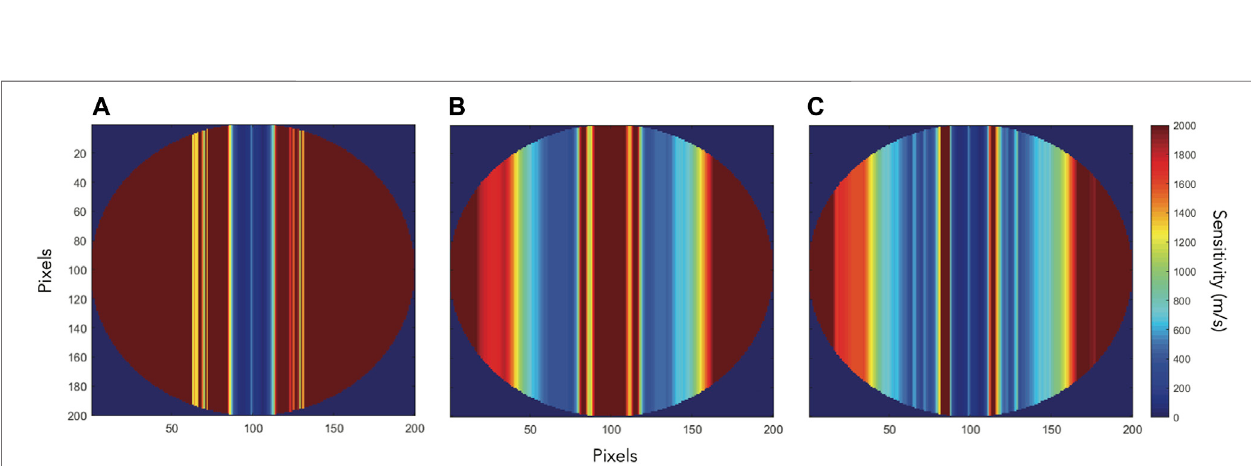
FIGURE 2 | (A) : “ velocity ” or “ MOF ” image, displaying the absorption line feature near the top of the disk. (B) : “ continuum ” image, with no velocity sensitivity, recorded simultaneously and on the same detector as the velocity image. (C) : the velocity image divided by the continuum image to produce the fi nal data product: a Dopplergram, where pixel intensity values correspond to Doppler velocities towards and away from the observer within the dark absorption band. This data was collected during the 24-day observing run on the AEOS 3.6 m telescope. Particularly, these frames are from the night of 12 August 2020, with a 13.76 km s − 1 relative velocity between observer and Jovian disk center. All three frames are from a single integration and have had basic data reduction steps (bias, dark, leak image, and fl at- fi eld calibration, further detailed in Section 4 ) applied. Each image has been normalized to its respective maximum value for ease of viewing, and each has 200 pixels across the Jovian disk.